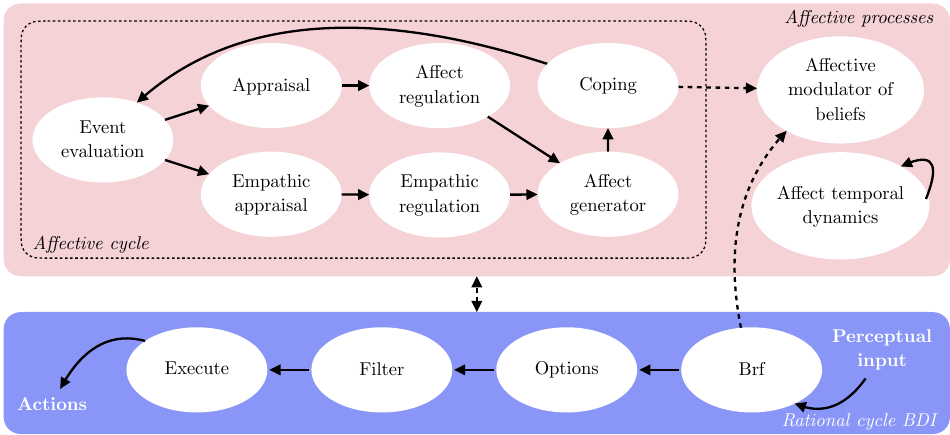
Figure 11. GenIA 3 : a General-purpose Intelligent Affective Agent Architecture that integrates BDI and affective processes [9]. Sequences are represented as solid line arrows, subprocess as dashed line arrows, and exchange of information as dotted line